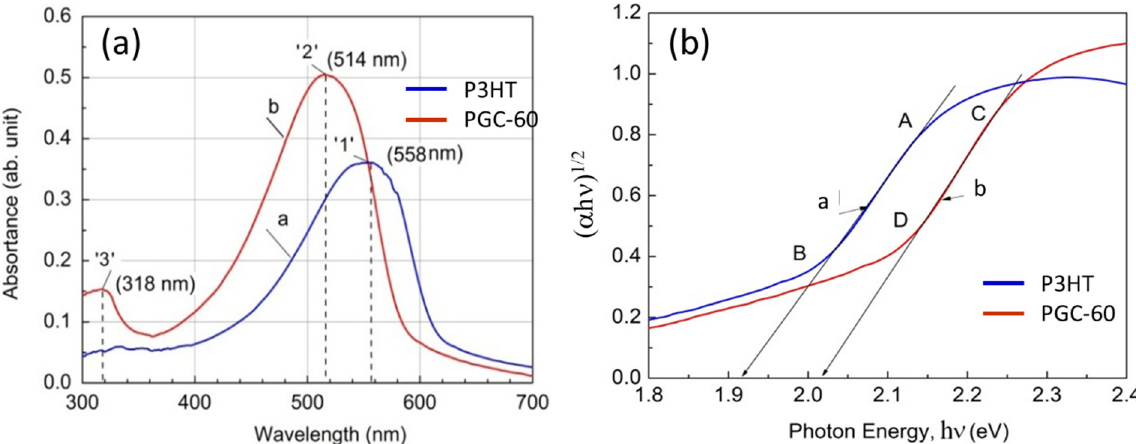
Figure 4. ( a ) UV-Vis absorptance spectra and ( b ) plots of ( α h ν ) 2 vs. h ν of drop-casting P3HT and PGC-60 composite films.